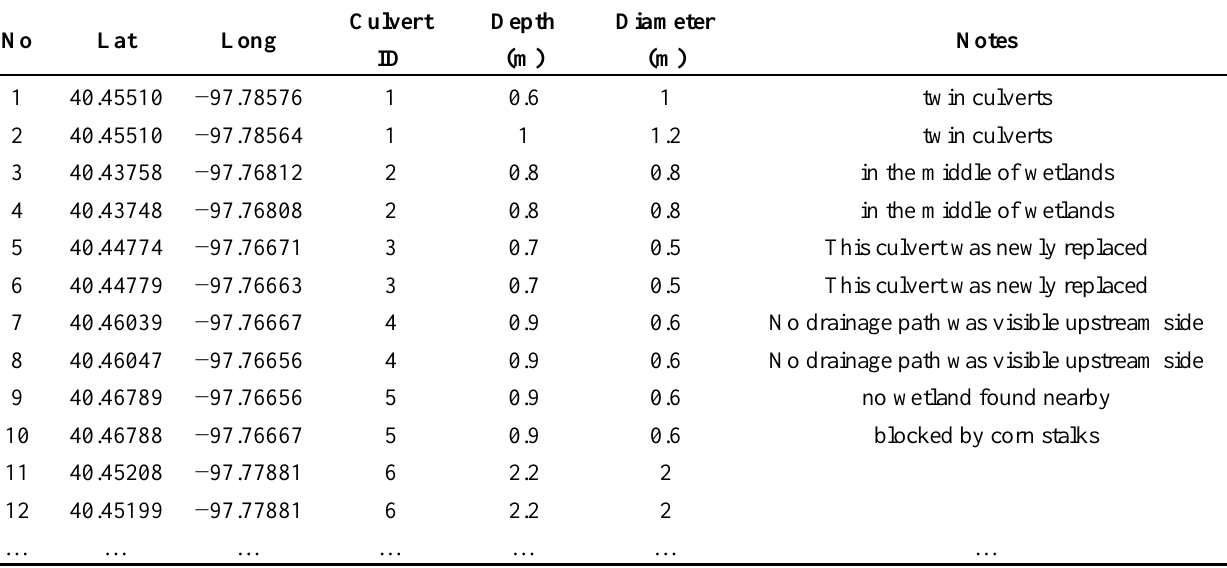
Table 2. Field collected culvert data in the form of points (only the first six pairs